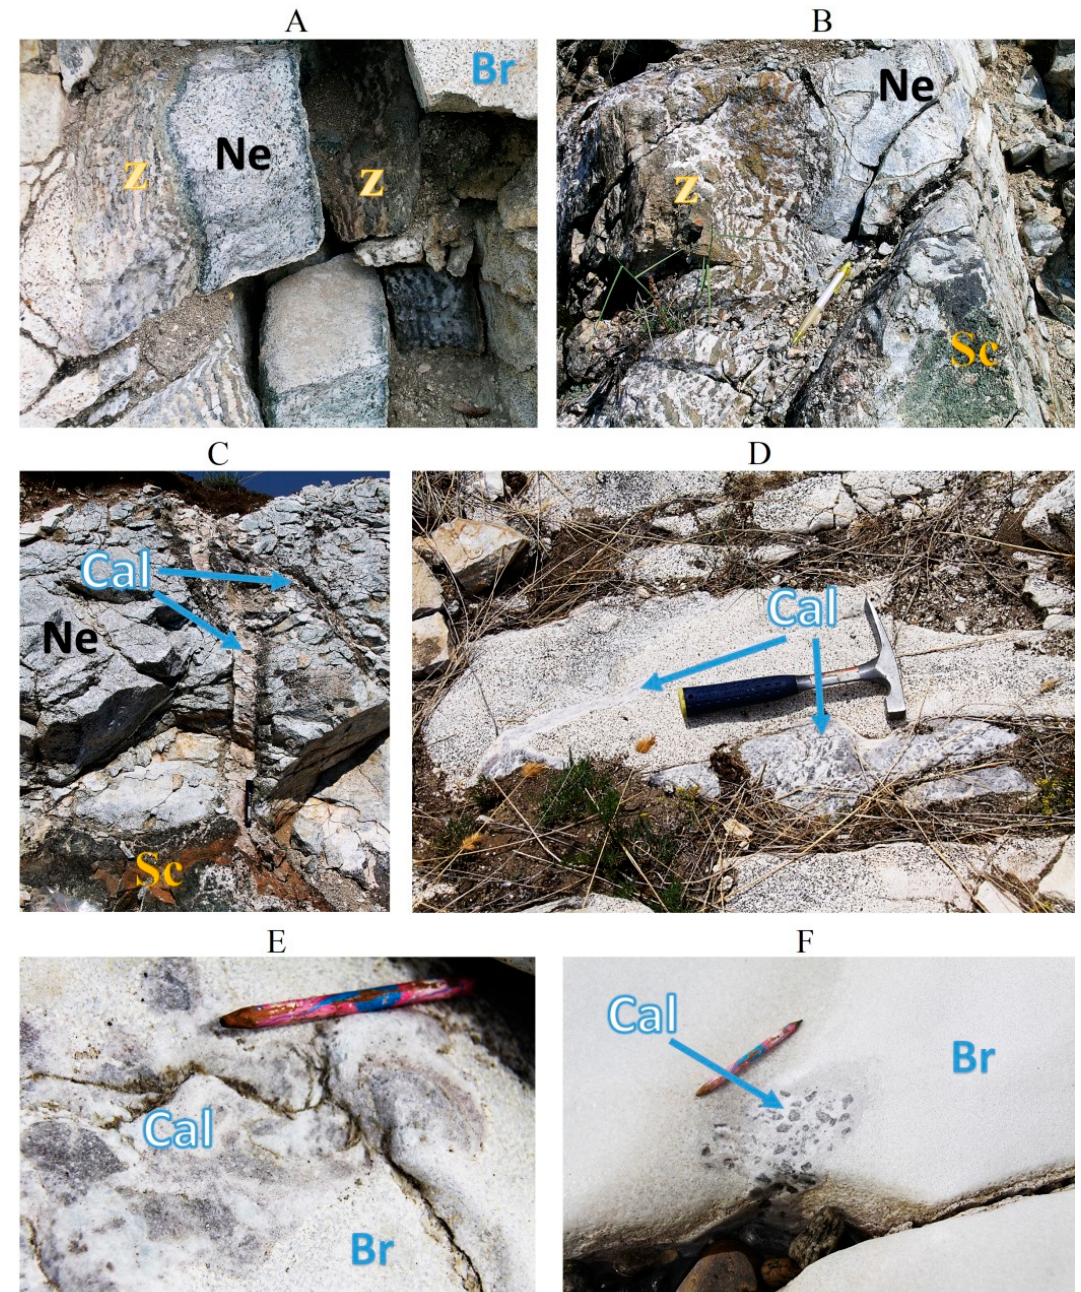
Figure 5. Photographs of perovskite-bearing metasomatic rocks: ( A , B ) Banded skarn (Z) at contacts of a thin vein of Ne–syenite (Ne); ( C ) calc–silicate veins (Cal) in Ne–syenite, with Fo-Spl-Cpx-Phl skarns (Sc) at the syenite-brucite marble (Br) contact; ( D ) Fo-Spl calc–silicate vein (Cal) with an offshoot in brucite marble (Br); ( E , F ) dismembered fragments of Fo-Spl calc–silicate vein (Cal) in brucite marble (Br).